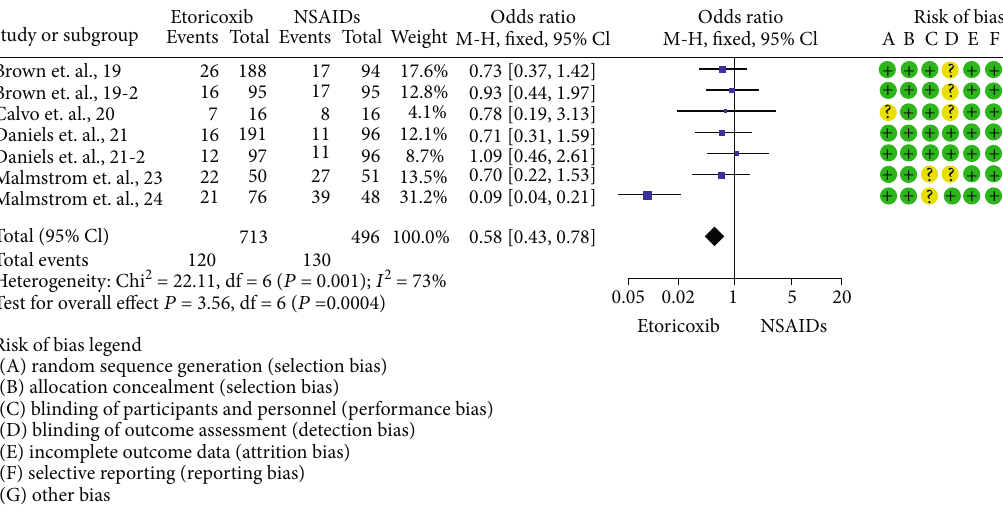
Figure 3: Overall evaluation of the number of patients requiring rescue analgesia.